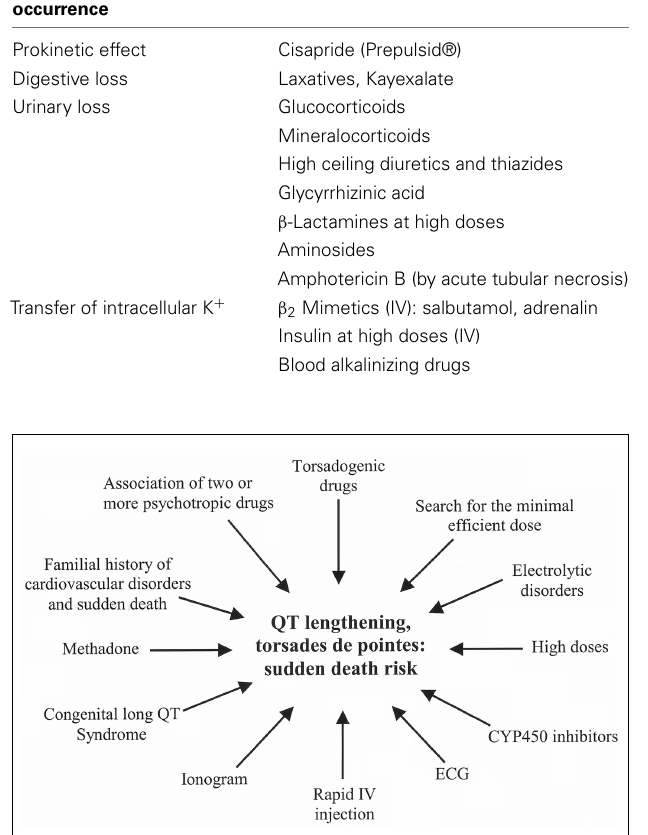
FIGURE 5 | How to handle prescription of a potentially torsadogenic psychotropic in patients at-risk.